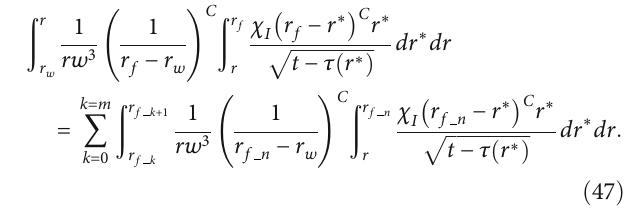
ffiffiffiffiffiffiffiffiffiffiffiffiffiffiffiffiffi p dr ∗ dr : t − τ r ∗ ð Þ